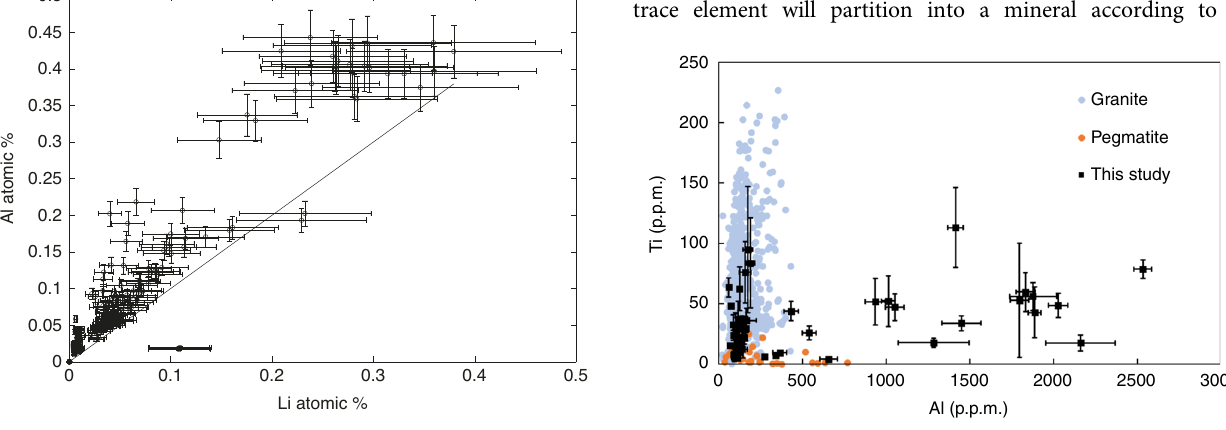
Fig. 3 Al versus Li in quartz. Line represents 1:1 correspondence of Li and Al. Correlation of Li with Al indicates possible charge coupling. Other monovalent cations, such as Na, may account for the remaining Al. Error bars are 3 σ based on internal measurement precision.